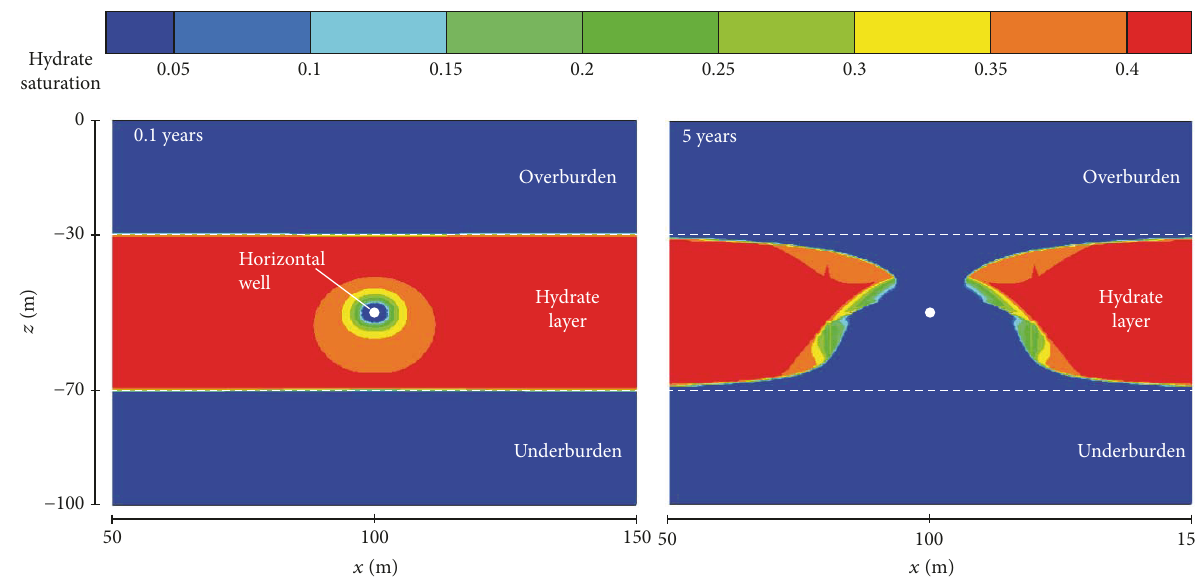
Figure 8: Spatial distribution of hydrate saturation in the reservoir during gas production from the unconfined Class 2 HBS.